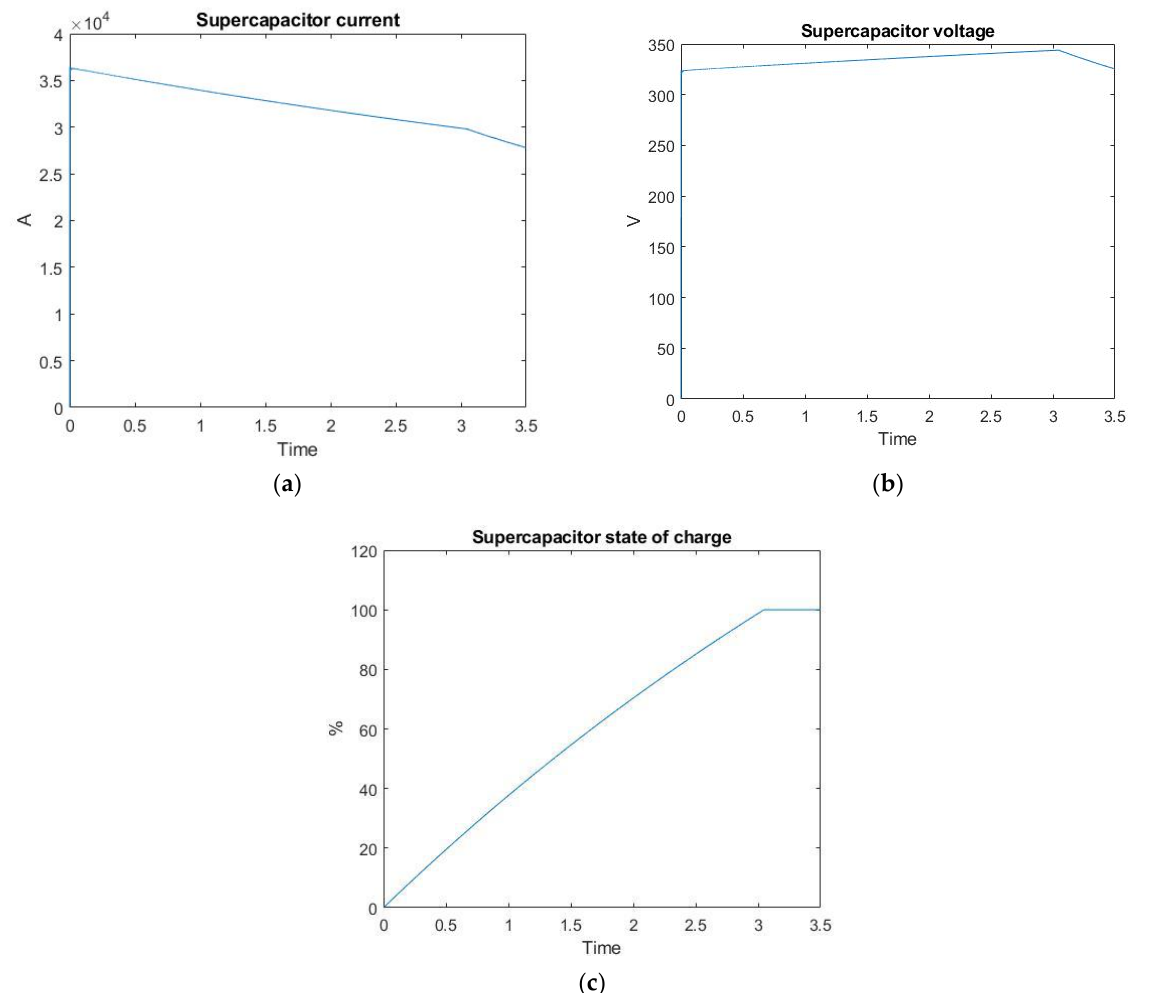
Figure 17. Block charge from 0%: ( a ) current; ( b ) voltage and ( c ) state of charge.